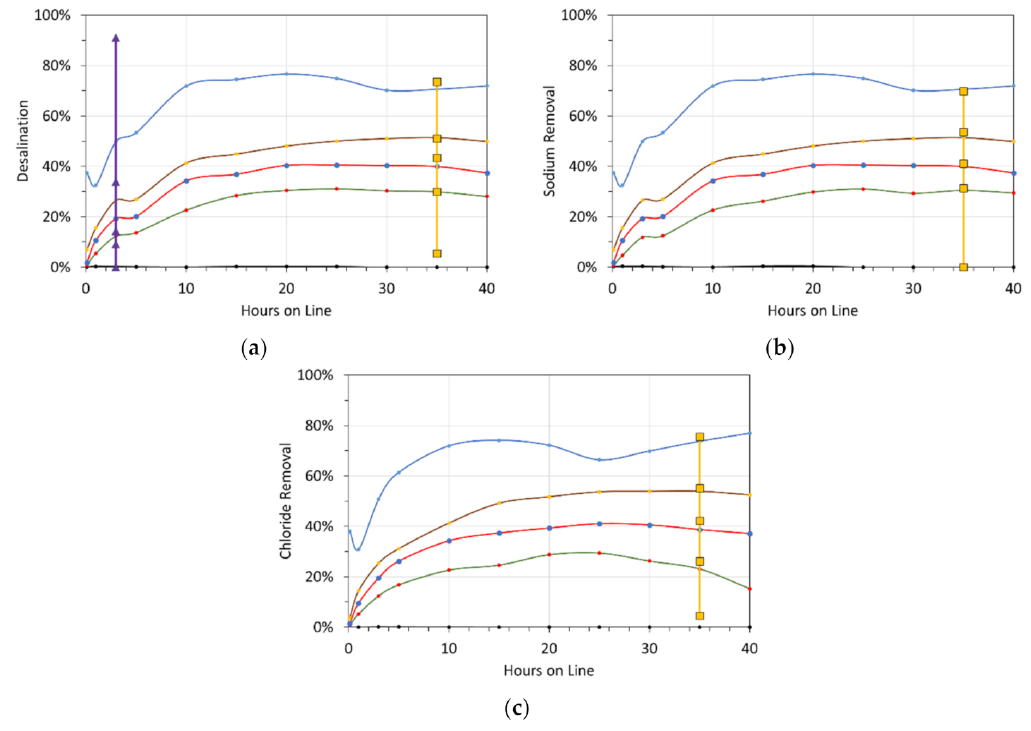
Figure A7. Probability distribution for ion removal versus hours on line. ( a ), Desalinations vs. hours on line; ( b ), Sodium removal versus hours on line; ( c ), Chloride removal versus hours on line.